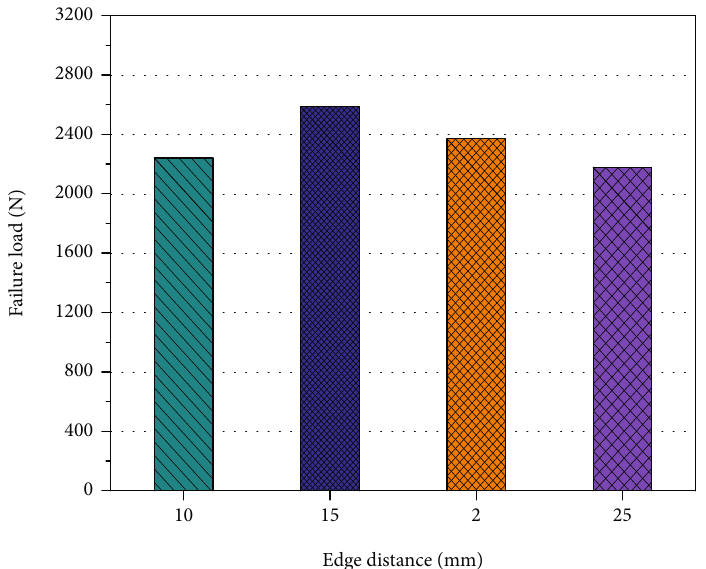
Figure 10: Variation of the failure load with edge distance for the studied CMC/superalloy double bolted joints at 750 °